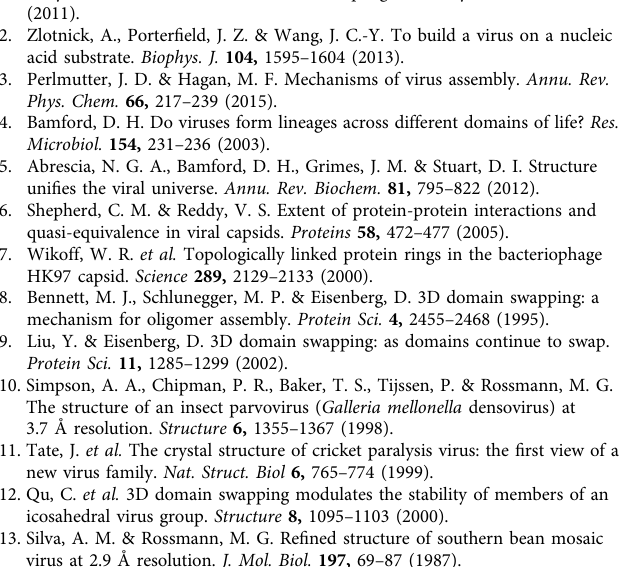
fitted in the NC vertex reconstruction).